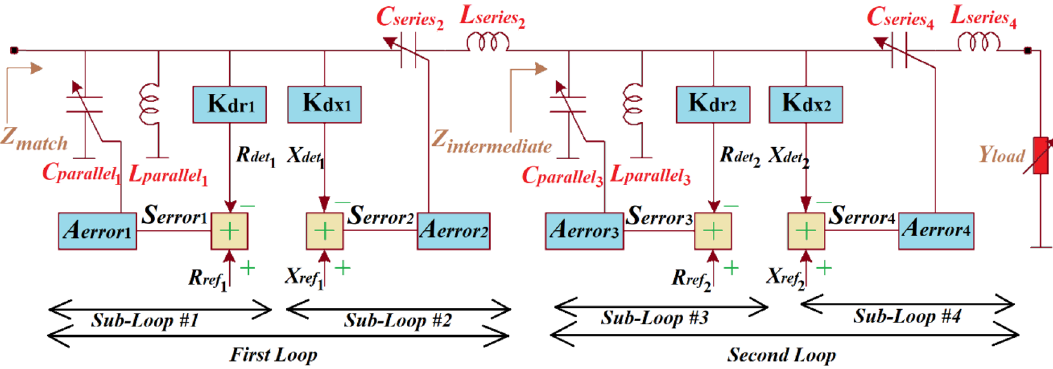
Figure 2. Schematic diagram for independent control of the matched impedance Z match of an LC-